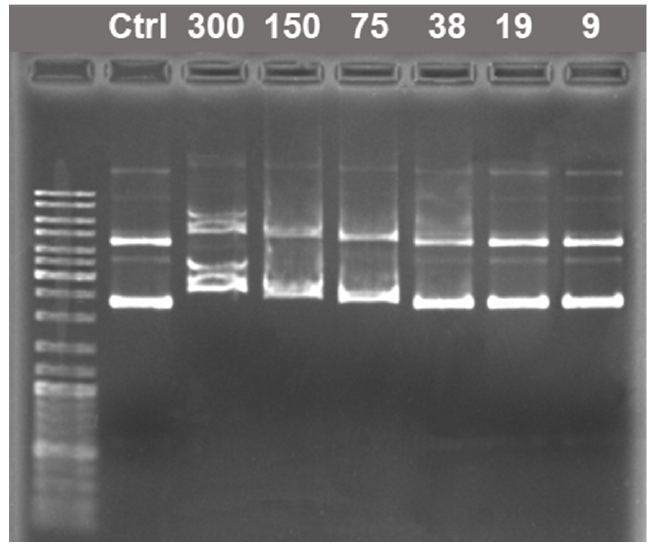
Figure 8. Electrophoretic mobility of pDNA in a complex with IA-12. Ctrl shows pure pDNA. N/P ratios are indicated above the corresponding wells. A DNA ladder from 100 to 10,000 bp was